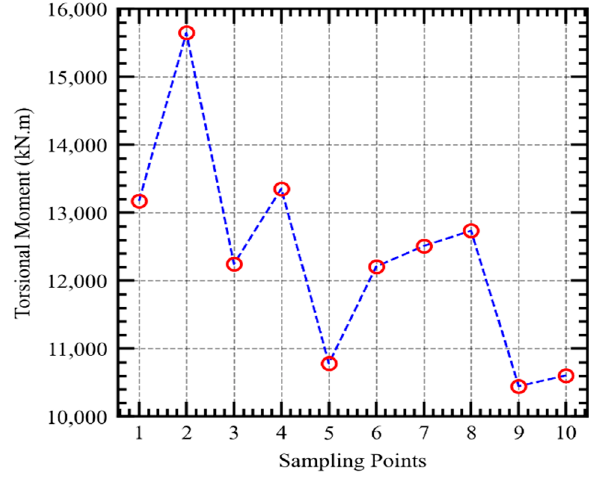
Figure 15. Torsional moment.